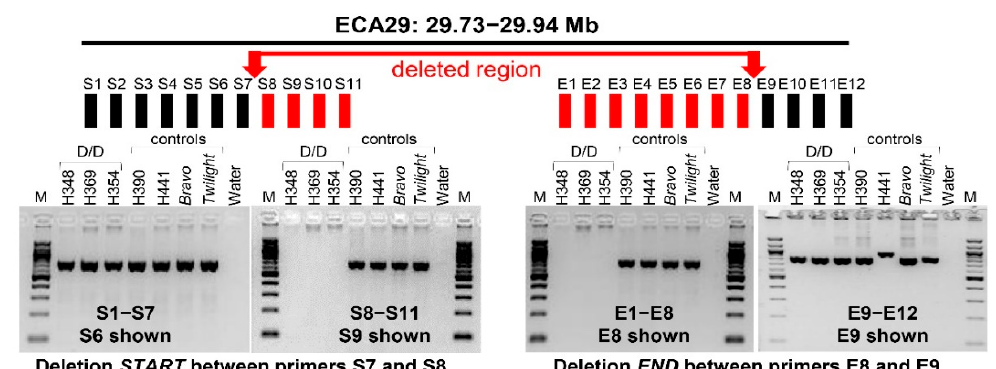
Figure 2. Demarcation of deletion breakpoints by PCR walking. Black horizontal bar at the top denotes the span of PCR walking in ECA29 between 29.73 and 29.94 Mb. Rectangles S1–S11 and E1–E12 denote sequence tagged sites (STSs) around the deletion start and end, respectively. STSs shown with black rectangles were located outside the deletion and STSs with red rectangles were inside the deletion. Red arrows indicate the deletion start and end sites. Representative agarose gel images with PCR results using STS primers outside and inside the deletion and gDNA from horses with homozygous deletion (H348, H369, H354) and 4 control horses are shown below the two deletion breakpoints. Details about PCR walking primers are in Supplementary Table 2.